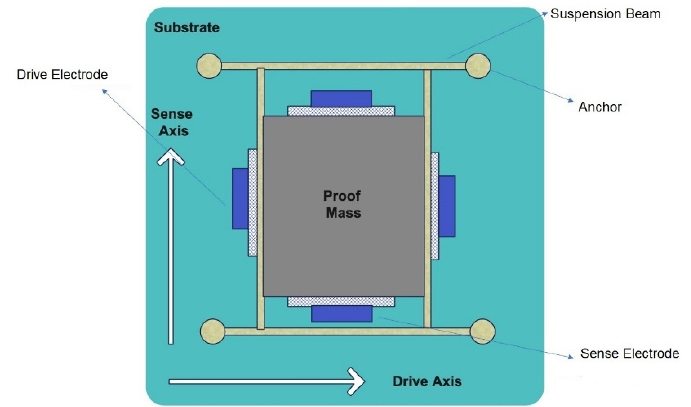
Figure 2. A Generic MEMS Gyro Structure.